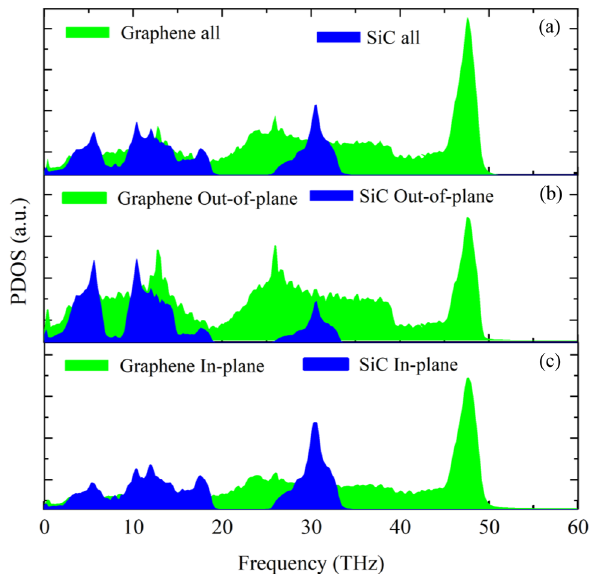
Figure 9. Phonon density of states (PDOS) of ( a ) all (including both in-plane and out-of-plane directions, ( b ) out-of-plane ( Z ) direction, and ( c ) In-plane ( X–Y ) direction for graphene and 2D-SiC.